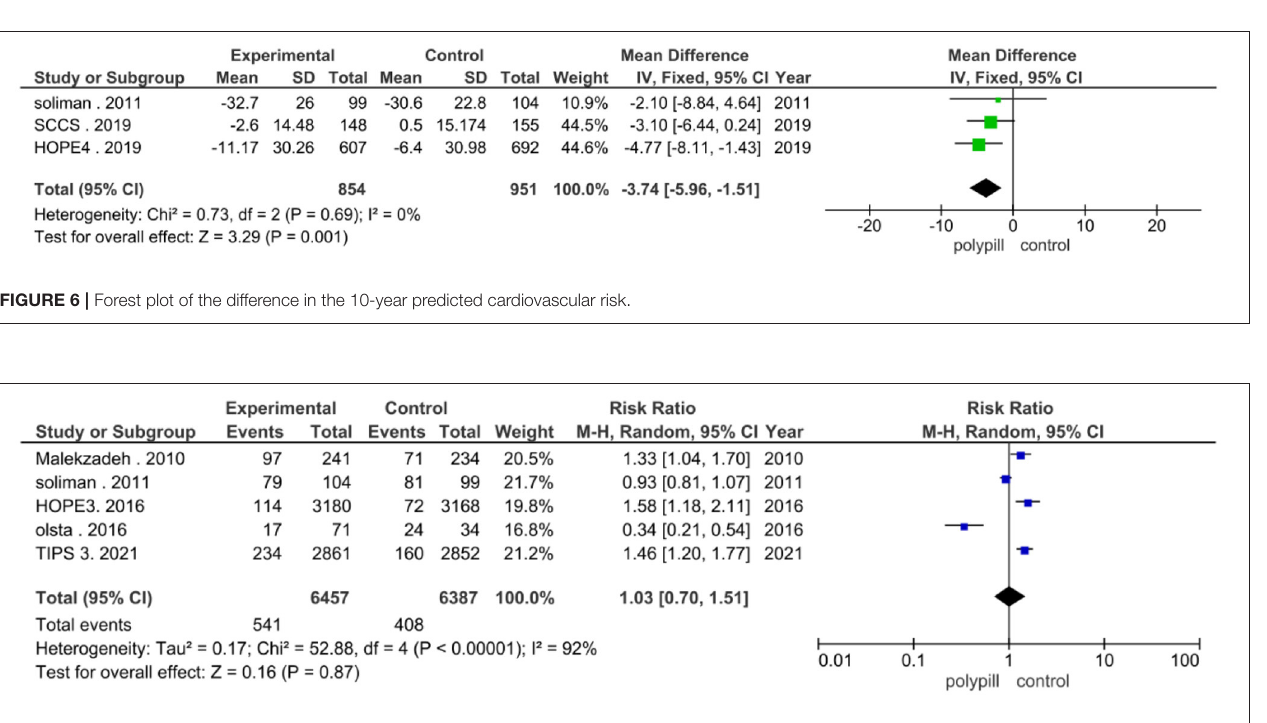
FIGURE 7 | Forest plot of the total adverse